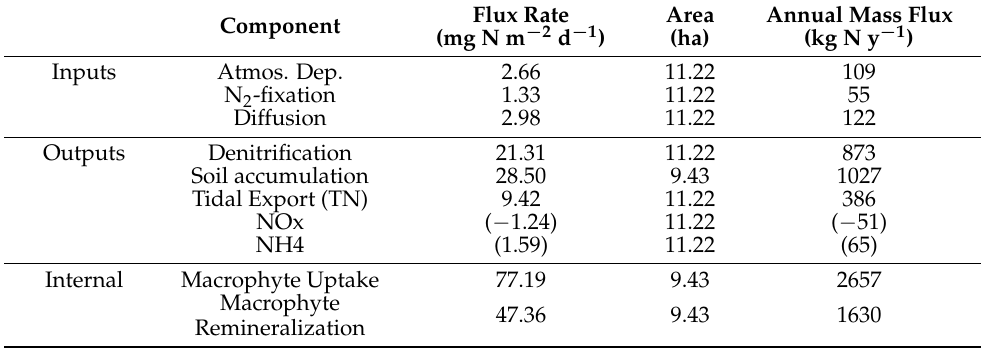
Table 7. Estimated N flux rates for the major terms in the N budget for the Cell 1B marsh. Indented terms and figures in parentheses were estimated separately but contribute to the primary term above.